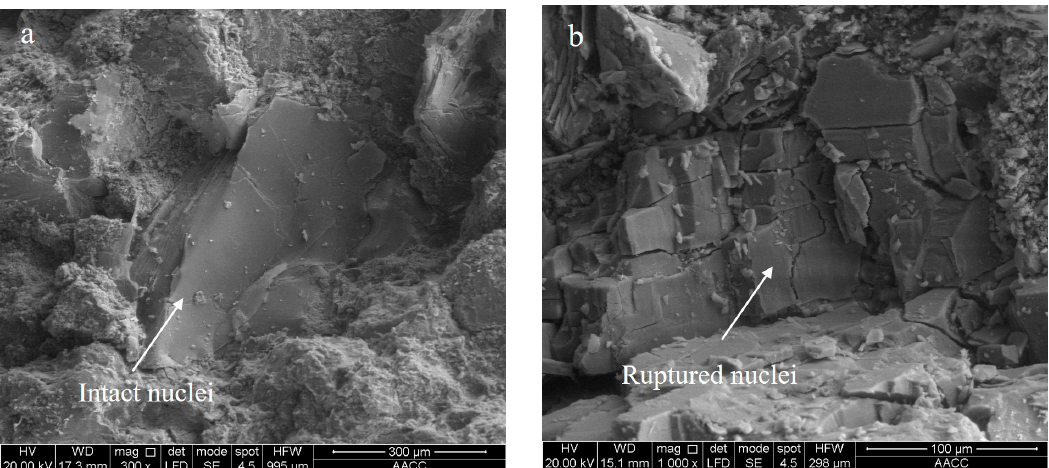
Figure 7. Mineral grain nucleus within the rock using SEM: ( a ) prior to ultrasonic vibration excitation; and ( b ) after ultrasonic vibration excitation.